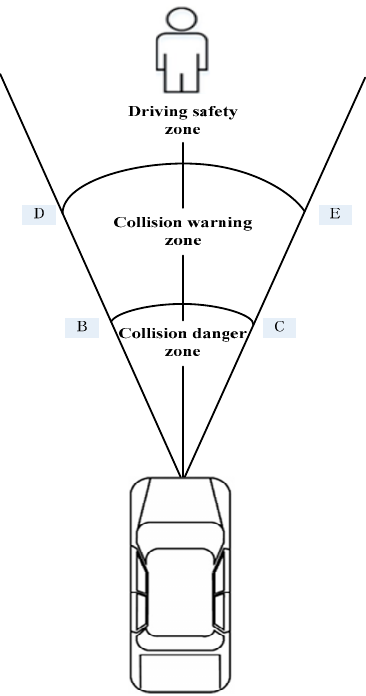
Figure 5. Security classification region of the AEB-P system.